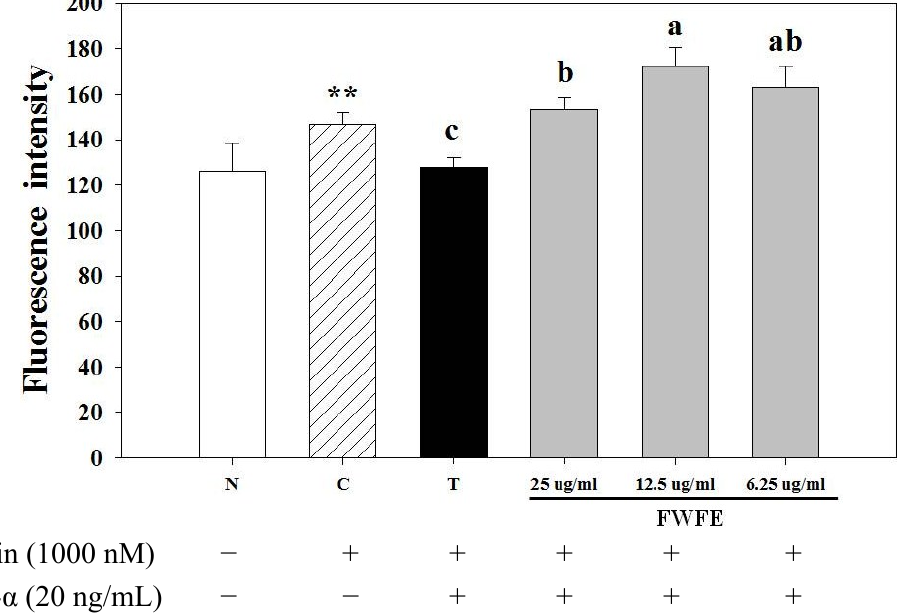
Figure 2. Effects of FWFE on glucose uptake in TNF- α -treated FL83B mouse hepatocytes. ** significantly different ( p < 0.01) from N (normal) group. Letters a,b indicate